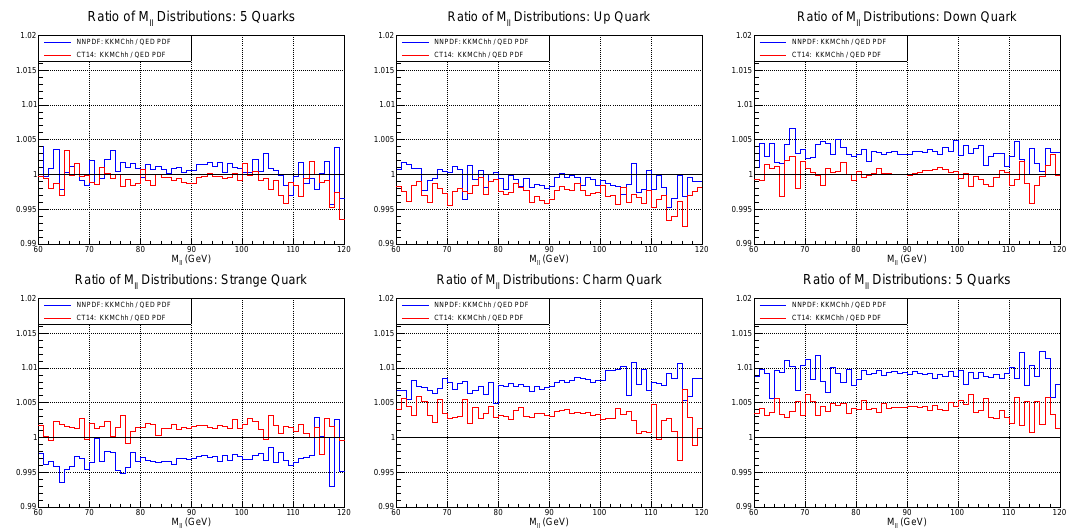
Figure 3: These figures show the ratio of a QED-corrected PDF set to a standard one for two sets: NNPDF3.1 in blue, and CT14 in red. In each case, the relative KKMChh ISR correction is shown for each standard PDF set: NNPDF3.1 in green, and CT14 in orange. The first figure includes all five quarks, while the remaining figures show the individual up, down, strange, charm, and bottom